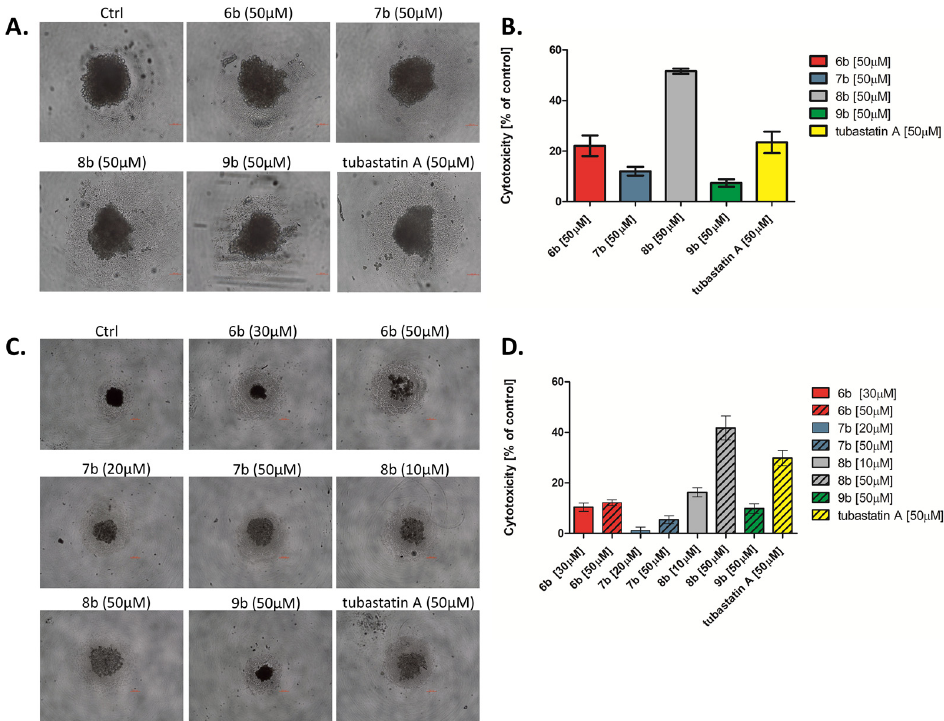
Figure 6. Inhibition of cell survival and growth of MDA-MB-231 tumor spheres treated with syn- thesized compounds. After 4 d, formed spheres were treated with synthesized compounds and tubastatin A at equimolar concentration (50 µM) for 72 h. The formation and growth of tumor spheres were examined and imaged with an Olympus CKX53, using 4×/0.13 and 10×/0.25 objec- tives. Scale bar: 100 µm. ( A ) MDA-MB-231 tumor spheres observed under the bright field, and ( B ) the cytotoxicity of compounds toward the MDA-MB-231 tumor spheres was investigated by MTT assay. ( C ) MDA-MB-231 cells were co-cultured with the tested compounds (IC 50 and 50 µM) in sphere culture conditions for 4 d. The formation and growth of tumor spheres were examined and imaged with an Olympus CKX53, using a 4×/0.4 objective. Scale bar: 200 µm. ( D ) The cytotoxicity of compounds in the co-treatment with MDA-MB-231 tumor spheres was investigated by MTT assay.